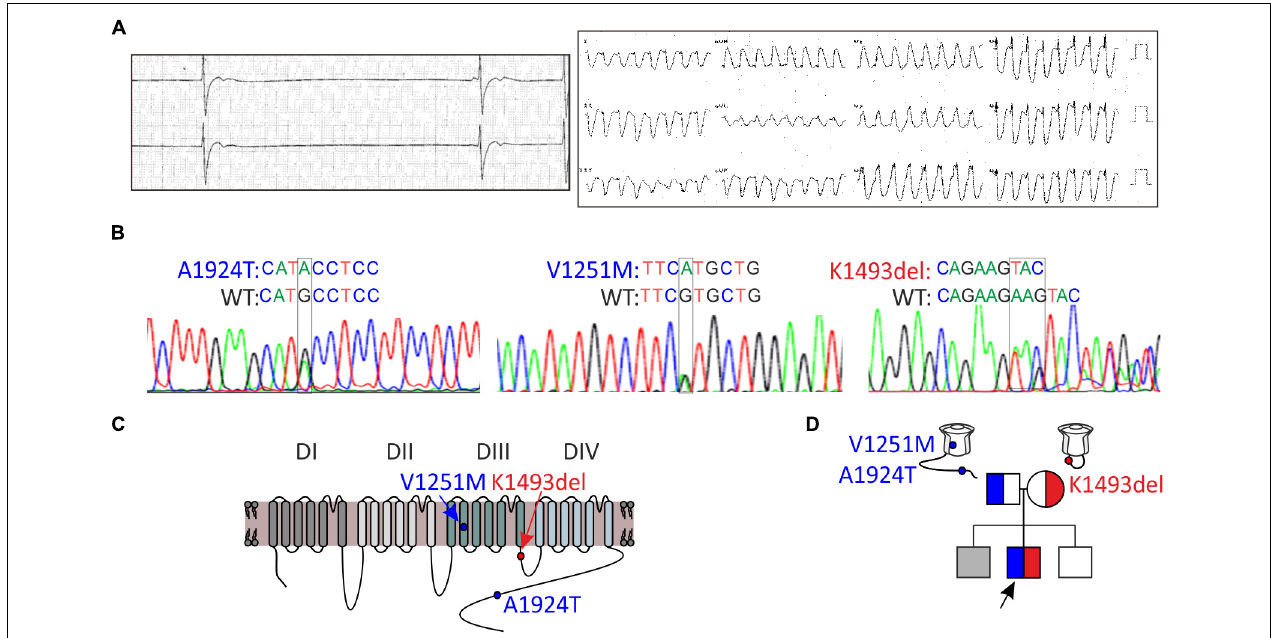
FIGURE 1 | Clinical and genetic characteristics of the proband. (A) Left, Holter recording at rest. Right, 12-lead ECG during exercise. (B) Sequence chromatogram of SCN5A variants. (C) Schematic illustration of Na V 1.5 protein and the location of the variants found. (D) Pedigree tree of the family. Circle indicates female, squares indicate male. The arrow points to the proband. In gray, suspected affected sibling. Red for the maternal allele variant, blue for the paternal allele